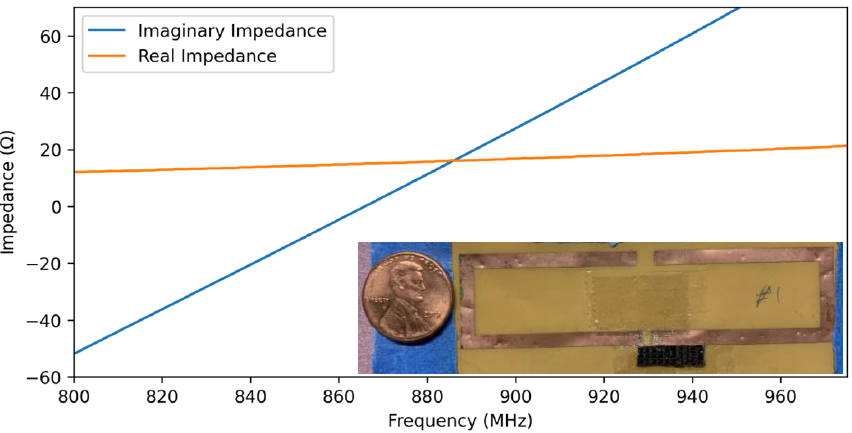
Figure 6. Real and imaginary impedances of the final antenna design with the fabricated antenna inserted as inset. Table 1. Simulated power transfer efficiency between the final antenna design and 3 MEMS resonance modes. MEMS1 and MEMS2 are the sensor and reference devices, respectively. MEMS and port numbers are detailed in Figure 4. Resonance Mode